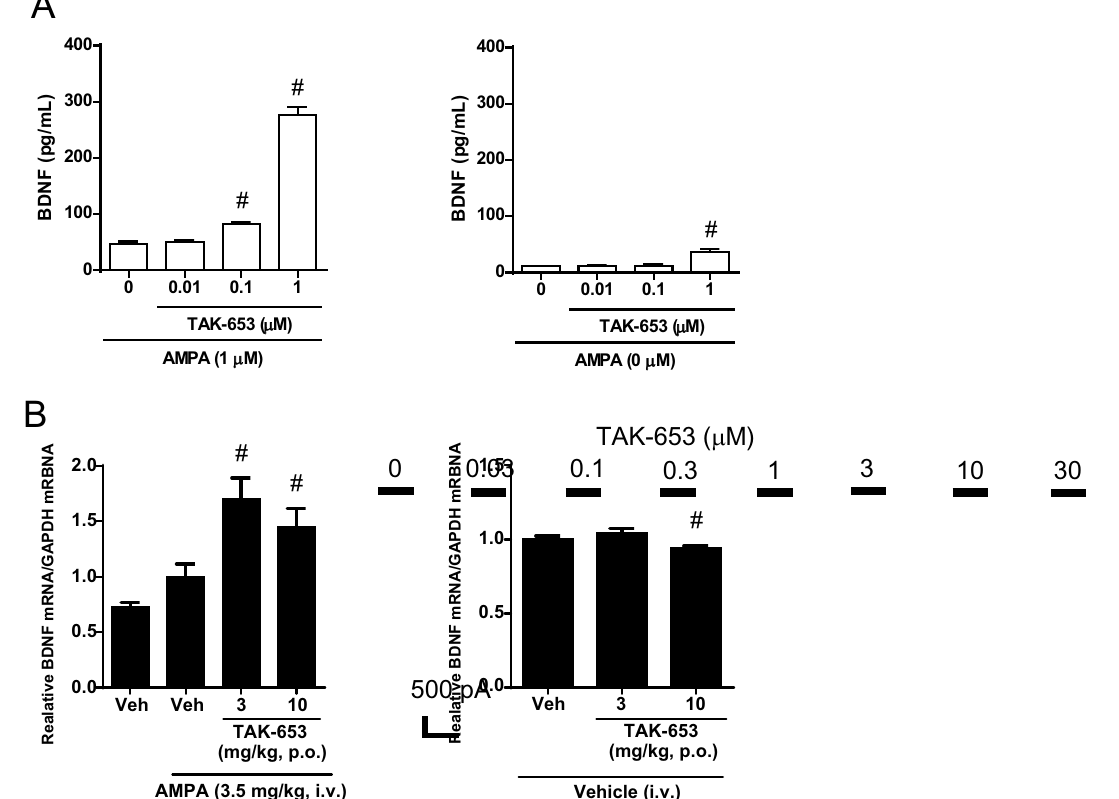
Figure 3. Effects of TAK-653 on BDNF expression in vitro and in vivo. ( A ) Effects of TAK-653 on BDNF protein levels in rat primary hippocampal neurons. Cells were treated with AMPA (0 or 1 μM) and TAK- 653 (0.01, 0.1, 1 μM) for 24 h and then were collected using lysis buffer. Cells in control group were treated with 1 μM AMPA and DMSO. Values were expressed as pg per mL. Data are represented as mean ± SD (n = 3). Statistical significance was determined by a two-tailed Williams’ test with significance set at # P ≤ 0.05 (versus control group; two-tailed Williams’ test). ( B ) Effects of TAK-653 on BDNF mRNA in hippocampus in AMPA (3.5 mg/kg, i.v.)-treated mice. TAK-653 (3 and 10 mg/kg, p.o.) was administered to mice 1 h before the administration of AMPA (3.5 mg/kg, i.v.) (left) or vehicle (right). Tissues were isolated 3 h after AMPA administration. Data were presented as the mean ± SEM (n = 23–24). # P ≤ 0.05 (versus vehicle-treated group; two-tailed Williams’